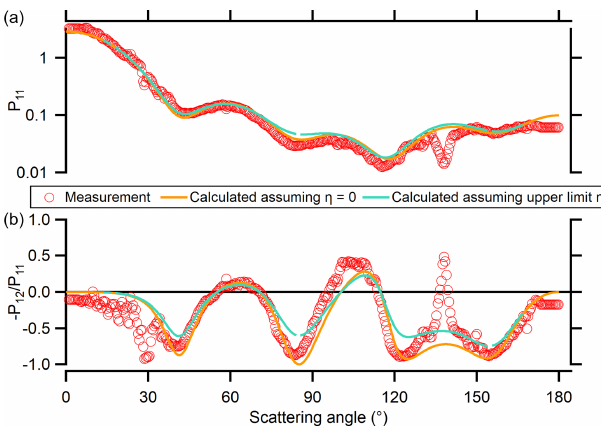
Figure 4. Phase function ( P 11 , a ) and degree of linear polariza- tion ( − P 12 /P 11 , b ) for λ = 660nm light scattered by D p = 900nm PSLs. Measurements are shown as red circles and the values calcu- lated from Mie theory are shown as solid lines. The gold line shows the values calculated if scattering plane rotation ( η ) is assumed to be zero. If we use an upper estimate of η , Mie theory predicts that the observations would follow the teal line. Stray light from the in- side of the instrument introduces noise at scattering angles around 30 and 135 ◦ for both data